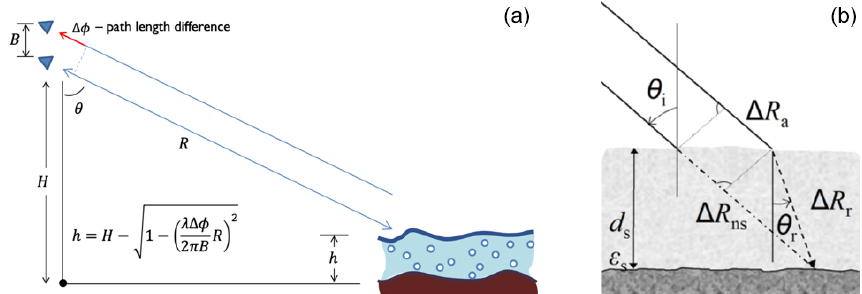
Figure 20. (a) Illustration of single-pass InSAR for mapping the snow surface. Using measured phase, (cid:49) φ , simple trigonometric calculations are used to estimate the relative height, h , of the scattering-phase center compared to the reference height, H . (b) When the phase center is below the snow surface, refraction in snow must also be taken into account. At low microwave frequencies (e.g., L-band) in dry snow, the phase center is often the snow–ground interface, and due to the slower electromagnetic velocity in snow, phase changes are related to changes in snow depth and